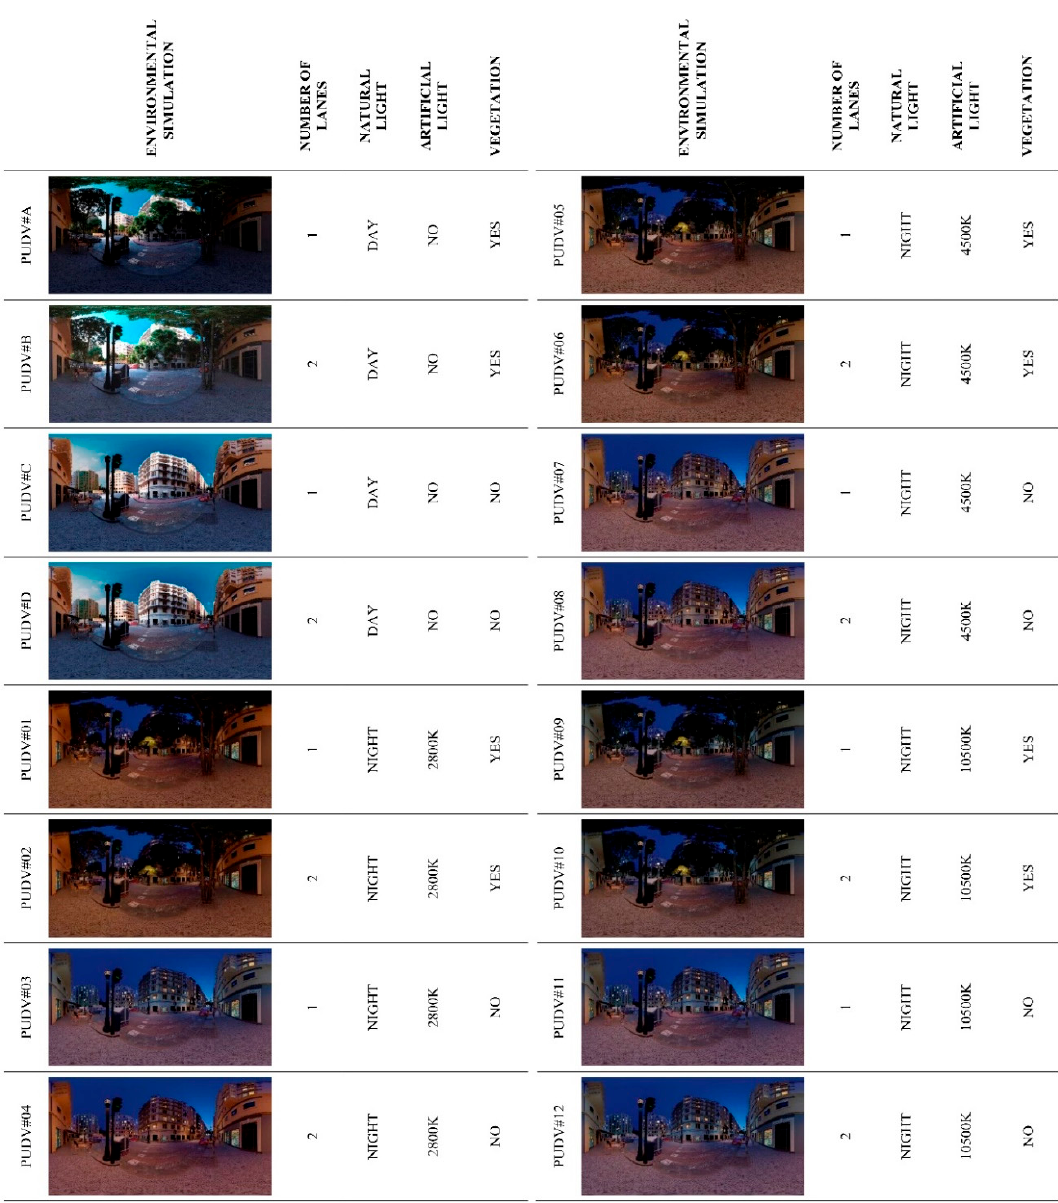
Figure 2. Comparison of the physical scenario (left) and its virtual replica (right; parameterization of urban design variable (PUDV) # B).